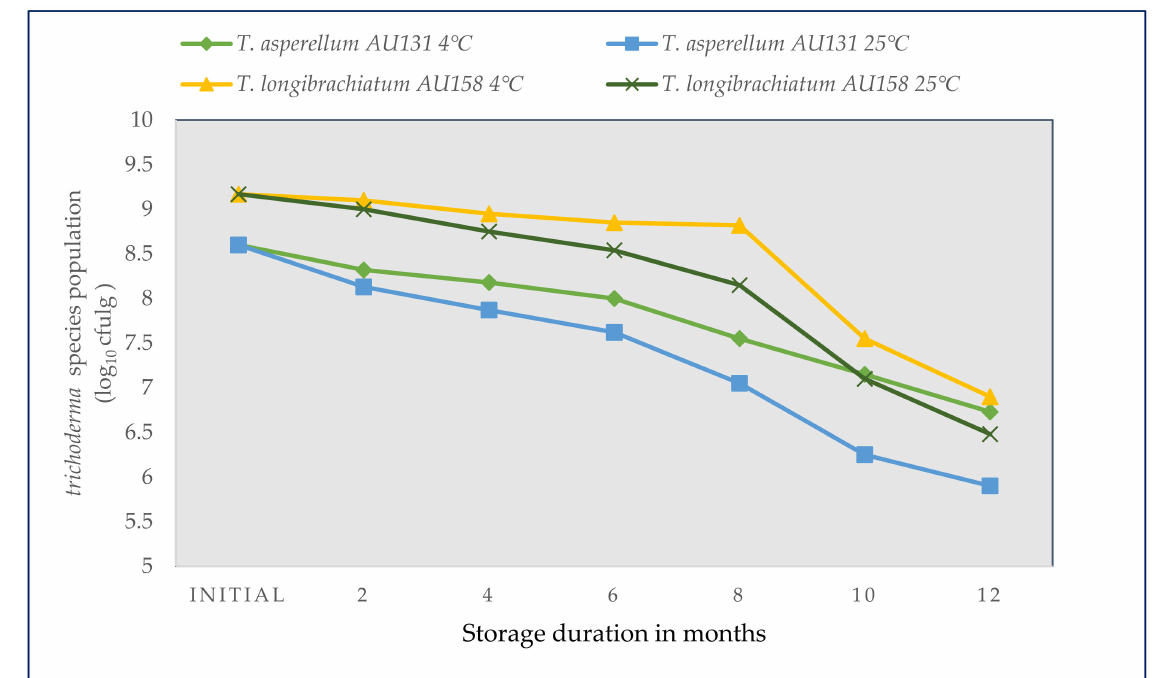
Figure 7. Shelf life and viability of bio-fungicides under two different storage